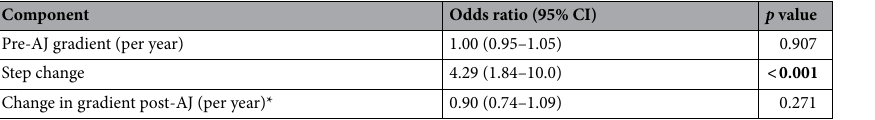
Table 2. Segmented regression analysis of CRRM. Results are from a segmented binary logistic regression model, as described in the methods. Bold p values are significant at p < 0.05. *Represents the difference between the gradients in the pre- vs. post-AJ periods. Re-parameterisation of the model found the gradient in the post-AJ period to have an odds ratio of 0.90 per year (95% CI 0.75–1.08, p =